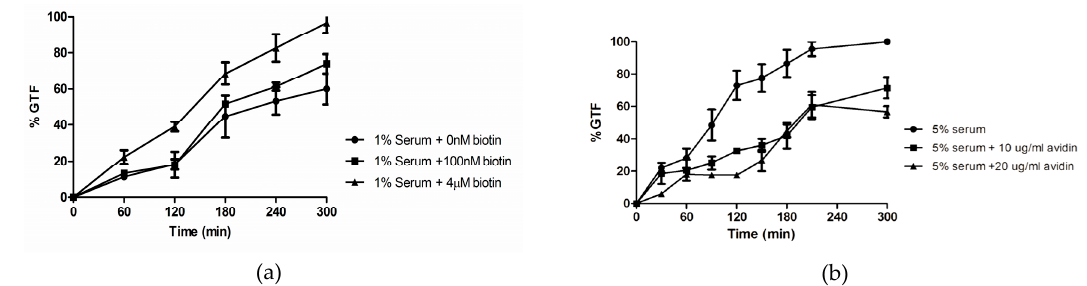
Figure 5. Effects of increased and decreased available biotin on GTF. Three times washed inocula were incubated at 37 °C with rotary agitation at 220 rpm. ( a ) Exogenous biotin increases serum induction of GTF. Cultures were observed for 5 h, and plotted as: , no additions; , 100 nM biotin; and , 4 µM biotin. ( b ) Neutravidin reduces serum induction of GTF. Symbols: , no additions; , 10 µg/ml neutravidin; , 20 µg/ml neutravidin. Values shown are the average of triplicate experiments ± SD.